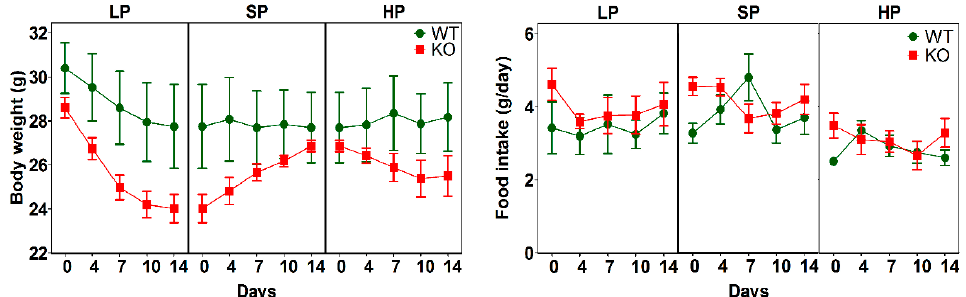
Figure 2. Body weight and food intake during diet intervention. Both parameters were recorded for male SLC6A19 ko and wt mice on low protein (LP = 5% protein energy), standard protein (SP = 25% protein energy), and high protein (HP = 52% protein energy) diets. Data are shown as mean ± SEM ( n = 5 male mice per group).